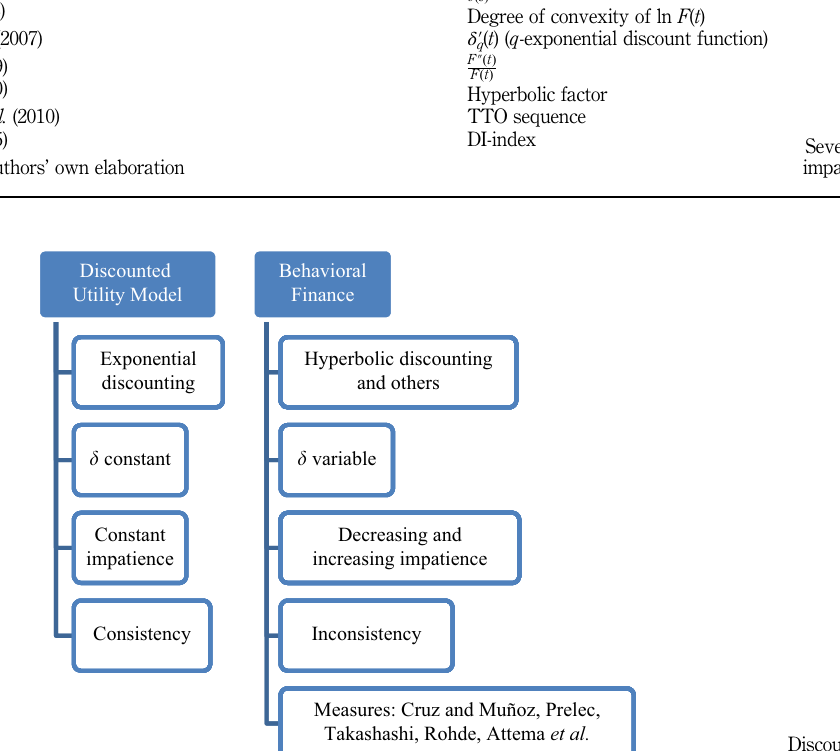
Figure 1. Discount utility